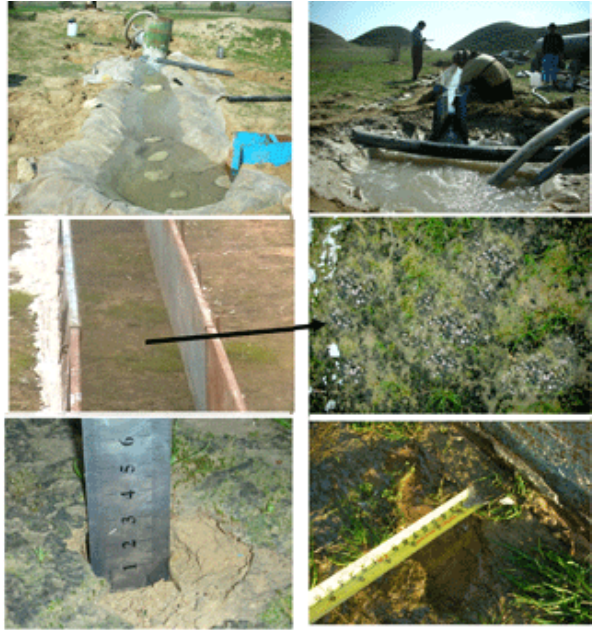
Figure 1. Flume, water supply, retention pond, overflow pipe, and Parshall flume (top photos); flume surface and vegetation (grass and pale pink lichen patch) in the rangeland (middle photos); sample of initiated head cut with height of 3cm in rangeland (bottom left photo); and abandoned land (bottom right